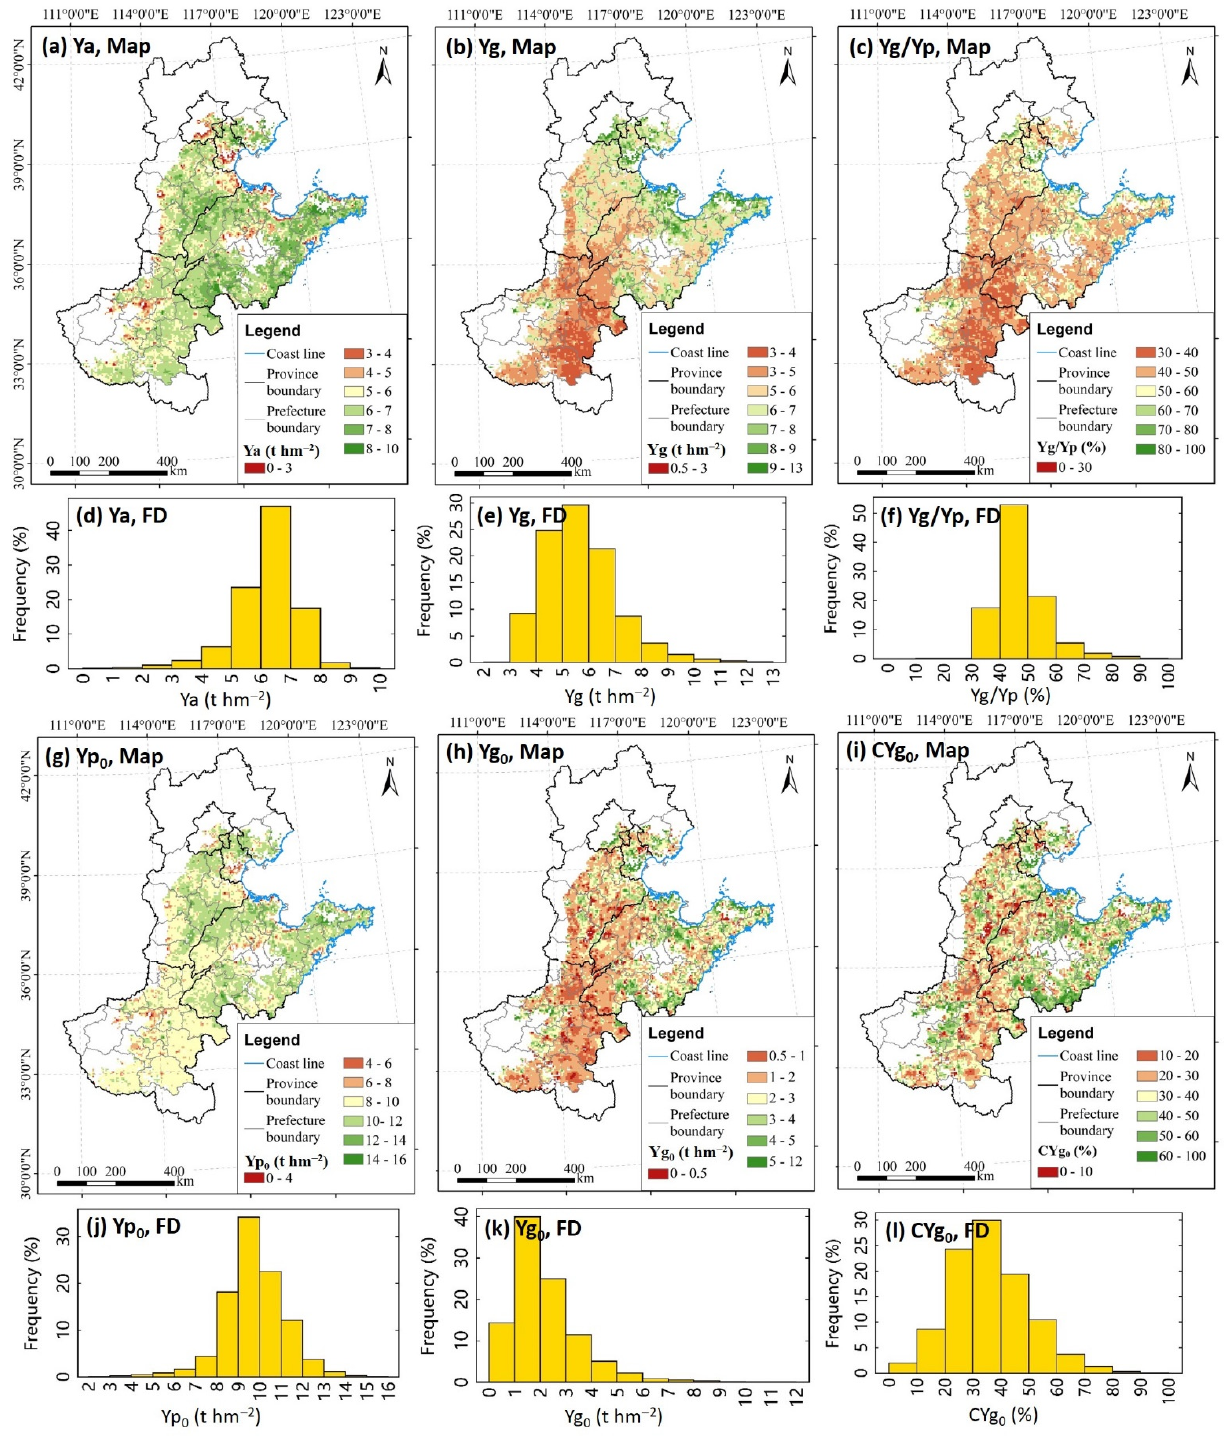
Figure 8. Maps of simulated mean annual Ya ( a ), Yg ( b ), the ratio of Yg to Yp (Yg/Yp) ( c ), potential yield limited by suboptimum SDT (Yp 0 ) ( g ), Yg induced by suboptimum SDT(Yg 0 ) ( h ), and the contribution of suboptimum SDT to Yg (CYg 0 ) ( i ), with a 5 km resolution in 2010–2015; and the frequency distribution (FD) of pixel-level values of Ya ( d ), Yg ( e ), Yg/Yp ( f ), Yp 0 ( j ), Yg 0 ( k ), and CYg 0 ( l ). The value ranges in the legends are right-closed and left-open. Annual 1 km Ya, Yp 0 , and Yp were aggregated to 5 km and then averaged in time to derive the mean annual Ya, Yp 0 , and Yp. Yg and Yg/Yp were derived from the 5 km Ya and Yp, and Yg 0 and CYg 0 were derived from the 5 km Yp 0 , Yg, and Yp. Each 5 km grid represents all 1 km cropland pixels inside the grid.